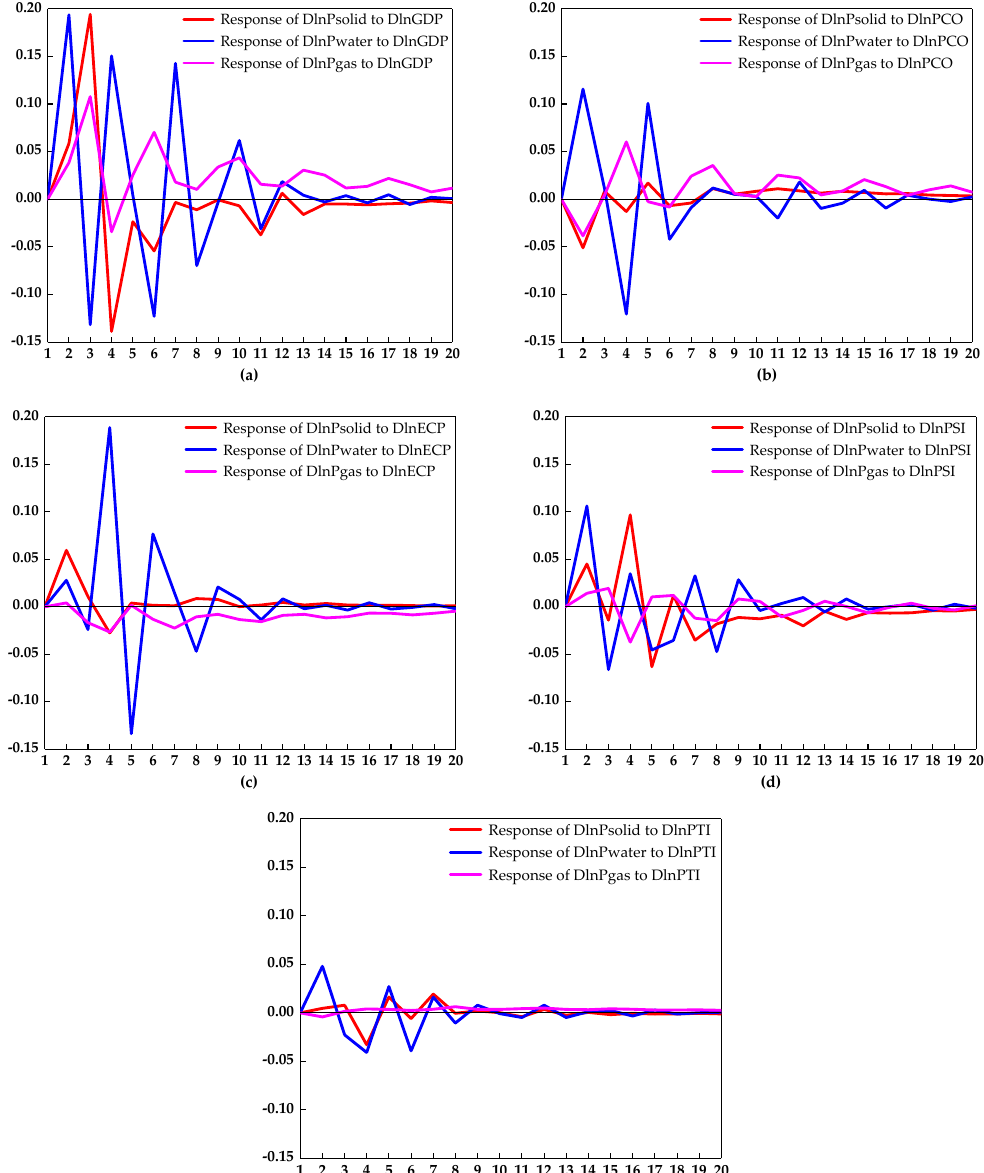
Figure 3. The impulse response of industrial “three wastes” emissions to socio-economic factors. ( a ) The response of environmental pollutants to DlnPGDP. ( b ) The response of environmental pollutants to DlnPCO. ( c ) The response of environmental pollutants to DlnECP. ( d ) The response of environmental pollutants to DlnPSI. ( e ) The response of environmental pollutants to DlnPTI. PCO, per capita raw coal output; ECP, energy consumption per unit of GDP; PSI, proportion of value-added of the secondary industry in GDP; PTI, proportion of technology investment in financial expenditure.